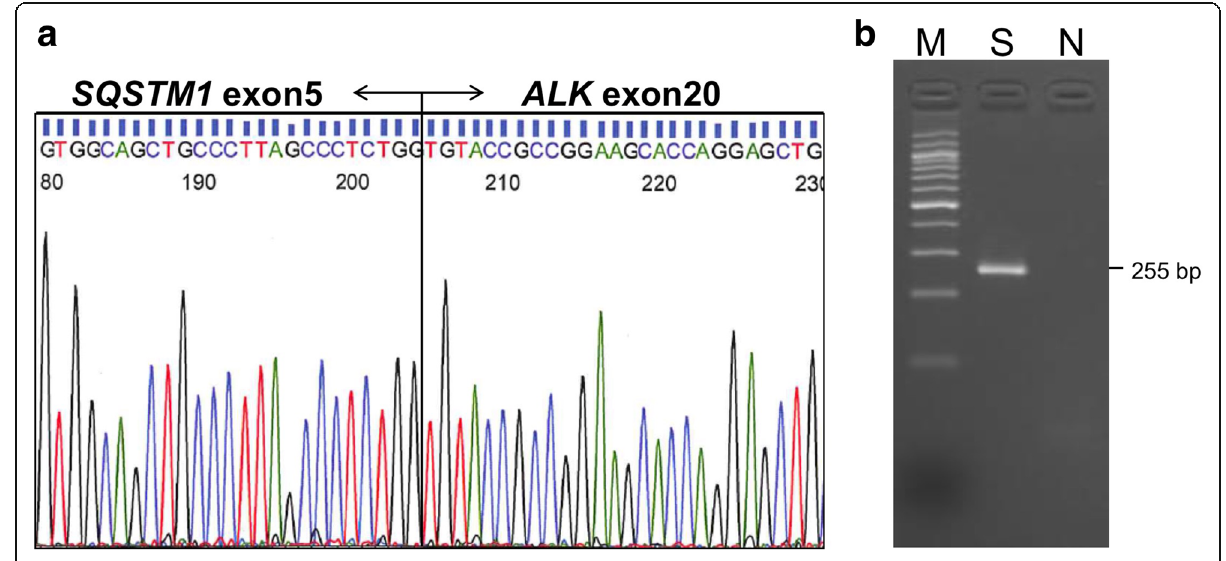
Fig. 7 The cDNA sequence around the SQSTM1-ALK fusion point ( a ) and specific RT-PCR for SQSTM1-ALK ( b )